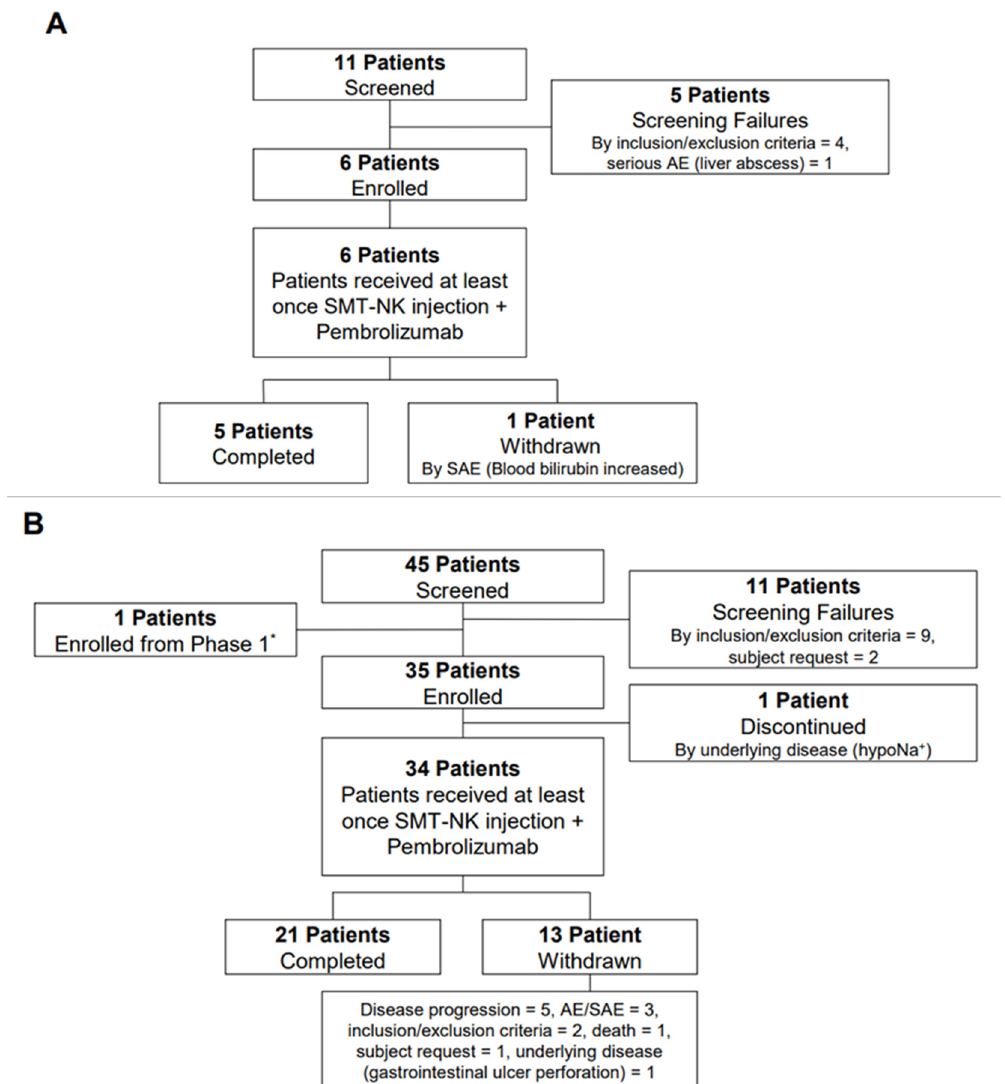
Figure 1. Trial profile. ( A ), phase I; ( B ), phase IIa. * One patient showed a stable disease after completion of the phase 1 trial and enrolled in the phase 2a trial. AE, adverse event; SAE, serious adverse event.